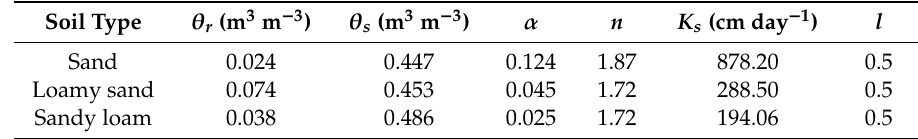
Table 2. Hydraulic parameters for the di ff erent soil types used in the simulations.